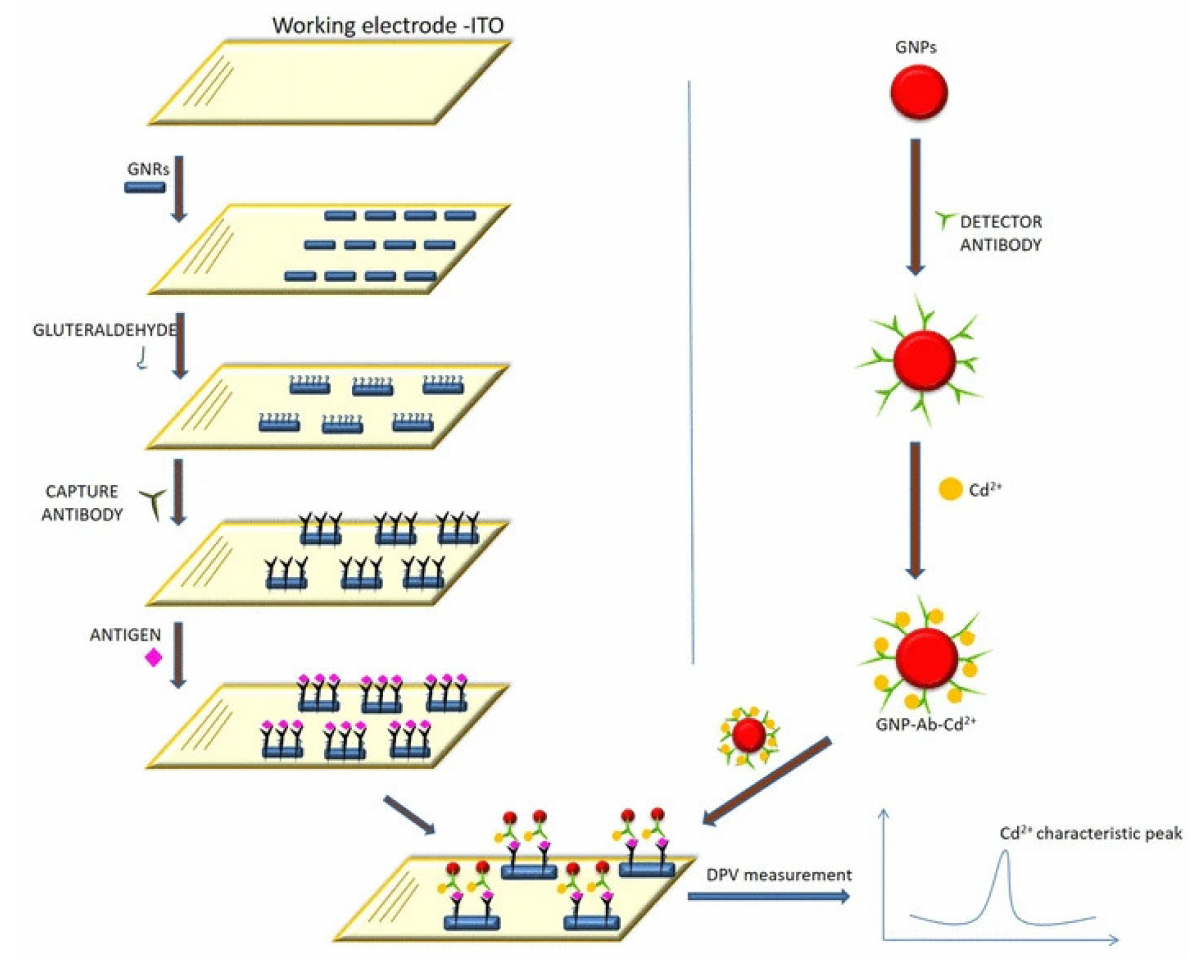
Figure 19. Fabrication scheme for a sandwich–type EC immunosensor and a DPV chart showing the level of attached electrochemical tracer (Cd 2+ ) on the AuNPs (GNPs). Reprinted with permission from [122], published by Springer–Verlag GmbH Germany,